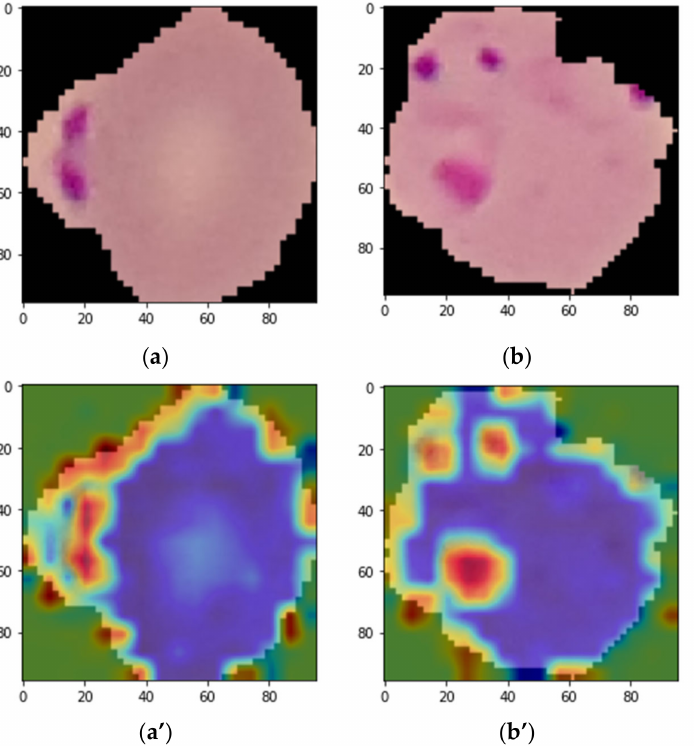
Figure 5. Grad-CAM localization map of the input images ( a , b ) and their corresponding overlaid heat map ( a ’, b